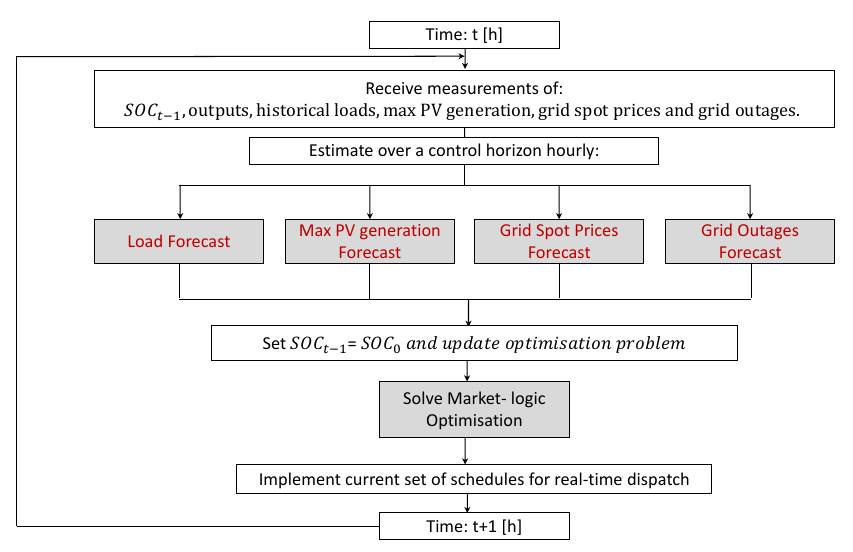
Figure 6. Model-predictive control for UMG market-based optimal